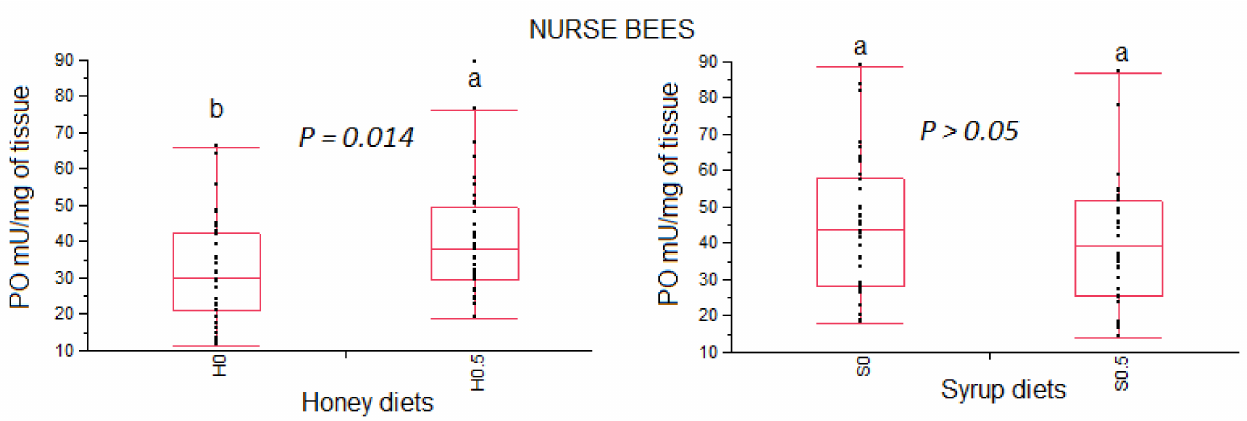
Figure 4. Box plots representing the phenoloxidase activity (PO mU/mg tissue) in nurse bees fed different diets. Data are presented as medians and range (min and max values). Different lowercase letters above the bars indicate statistical differences between honey or syrup diets according to the non-parametric Wilcoxon test. H = honey; S = syrup; 0, 0.5 = % ( w / w ) 1,3-1,6 β